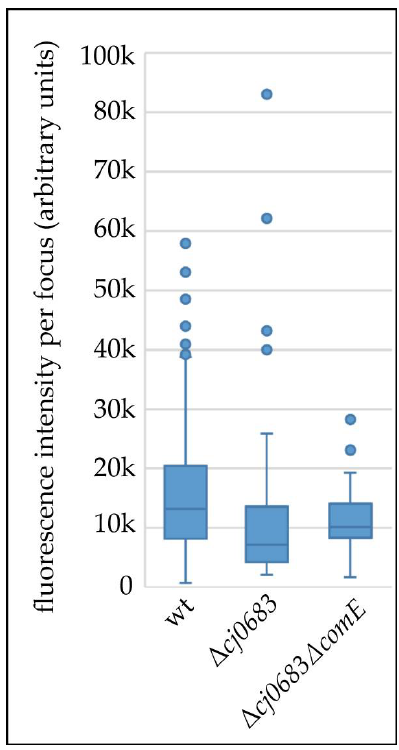
Figure 7. The median amount of DNA within single foci is only slightly reduced in rare uptake events of Δ cj0683 and Δ cj0683 Δ comE compared to the wild type. The boxplot length corresponds to the interquartile range (IQR; 50%) of data, the horizontal bar indicates the median value; whiskers represent 1.5 × IQR or the maximum/minimum value of the dataset; dots, outliers. Δ cj0683 ( n = 65 foci); Δ cj0683 Δ comE ( n = 37 foci); wild type ( n = 739